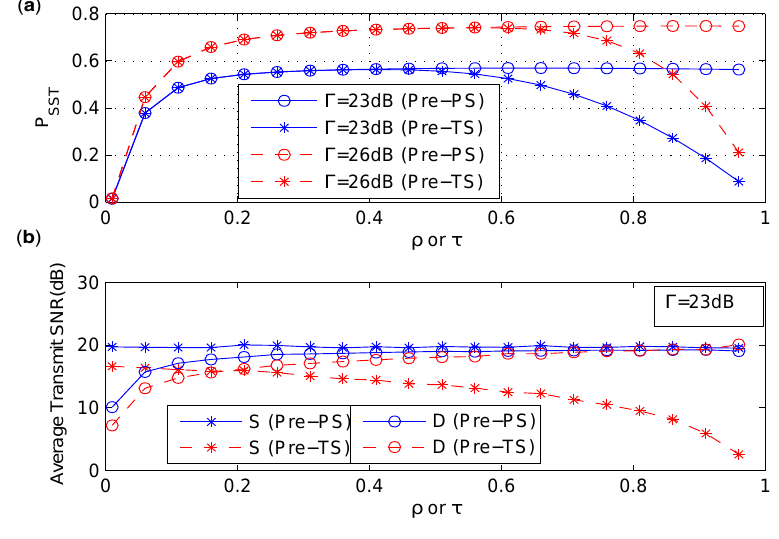
Figure 10. ( a ) P SST versus ρ or τ under different Γ . ( b ) The average transmit SNR versus ρ or τ under Γ = 23 dB